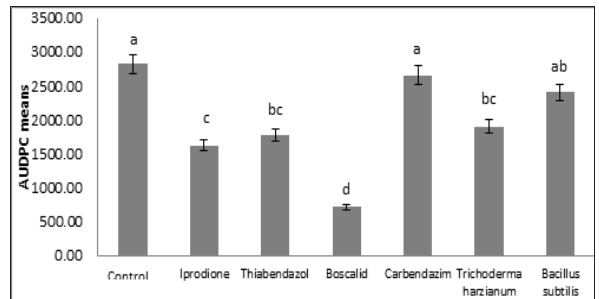
Figure 1: Combined analysis of AUDPC between study treatments Severity : The variance homogeneity test between patches with broccoli and without broccoli showed that there is homogeneity to perform the combined analysis. There are significant differences too between brassica block factors and treatment factors. There are no significant differences in the brassica treatment factor because brassica effect was a determining factor for the disease development and in the manifestation of symptoms and signs. The Tukey´s comparison test 0.05, showed that the brassica factor did not present significant differences between them, the severity percentage for both fields was statistically the same in regards of its severity manifestation in harvested bulbs. T1 (reference) and T5 (Carbendazim) are statistically equal and with high severity percentages of 51.76% and 45.41% respectively. T4 (Boscalid) showed a lower severity percentage regarding the other treatments with 9.35%, is statistically